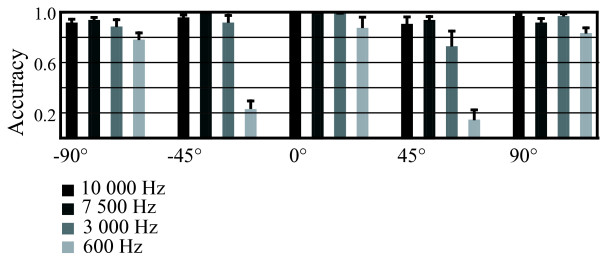
Direction discrimination accuracy. The subjects' grand-average accuracy in discrimination of the sound source direction. Stimuli with four different bandwidths were presented from five frontal horizontal directions. Stimuli with the narrowest bandwidth were poorly localized, particularly if originating from the oblique direction angels (-45°, 45°). Error bars indicate SEM.